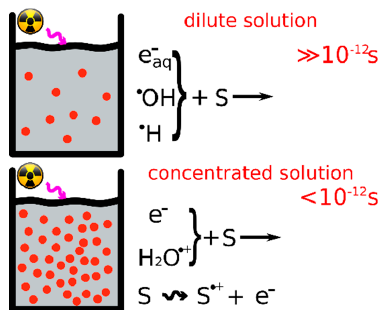
• + , and excess electron attachment 2 O